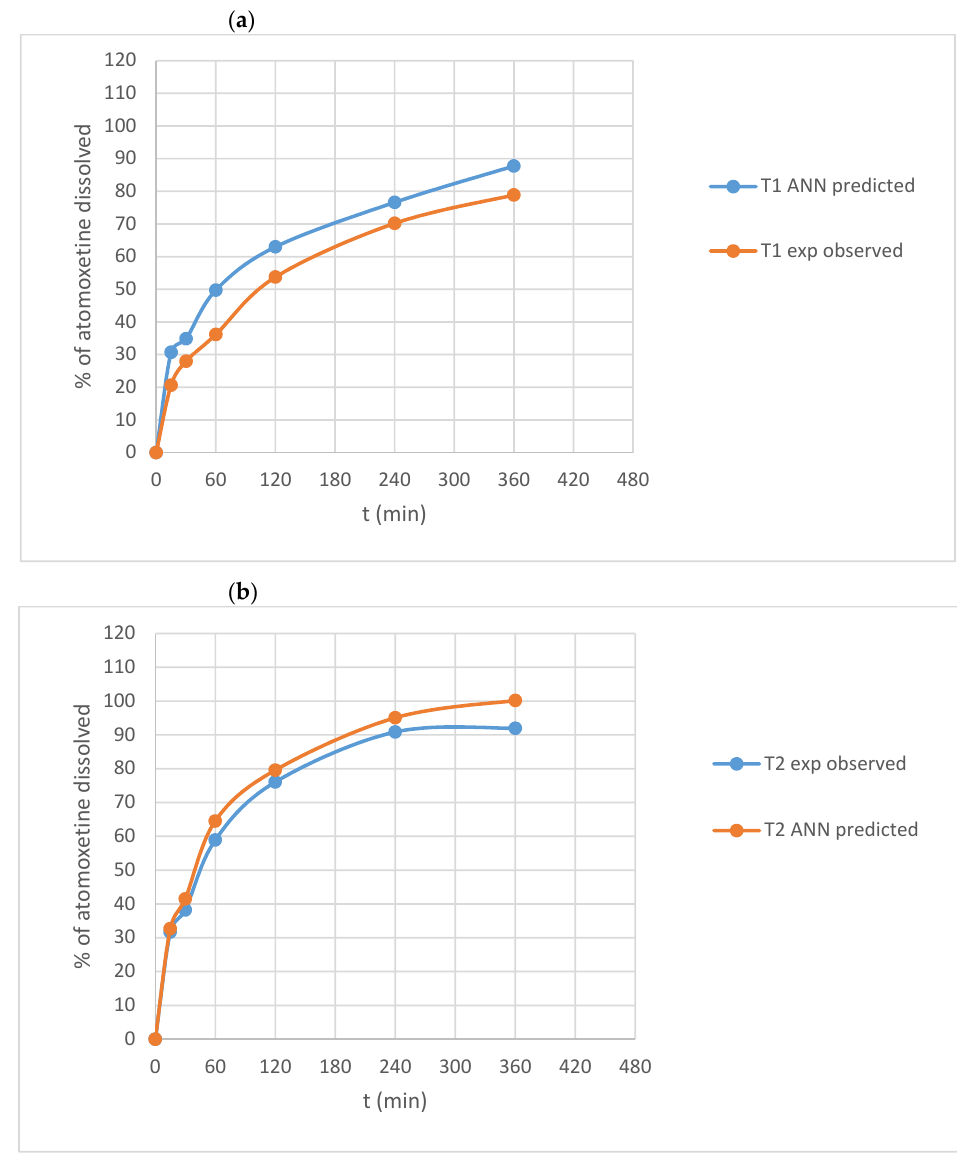
Figure 13. Experimentally observed versus GRNN-predicted dissolution profiles of ATH from formulations ( a ) T1 and ( b ) T2. These results demonstrated the ability of a trained GRNN to predict ATH dissolution profiles within a defined design space of tablet thickness between 0.75 and 3.00 mm and drug loading between 5% and 20%.